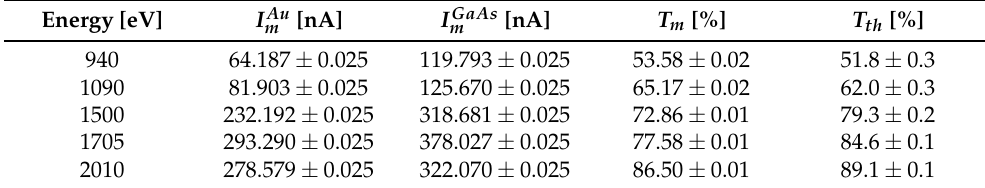
Table 1. Measured currents at different photon energies with devices with d abs = 4.5 µ m. For each energy, we measured the current illuminating the device through the Au/Cr contact (column 2) and directly in the GaAs layer (column 3). From these values, we calculated the transmission of the Au/Cr contact (column 4) and we compared it with the theoretical value obtained with IMD software (column 5). Of note is that the fluctuations associated with the photon energy were governed by systematic errors, which were in the order of 5